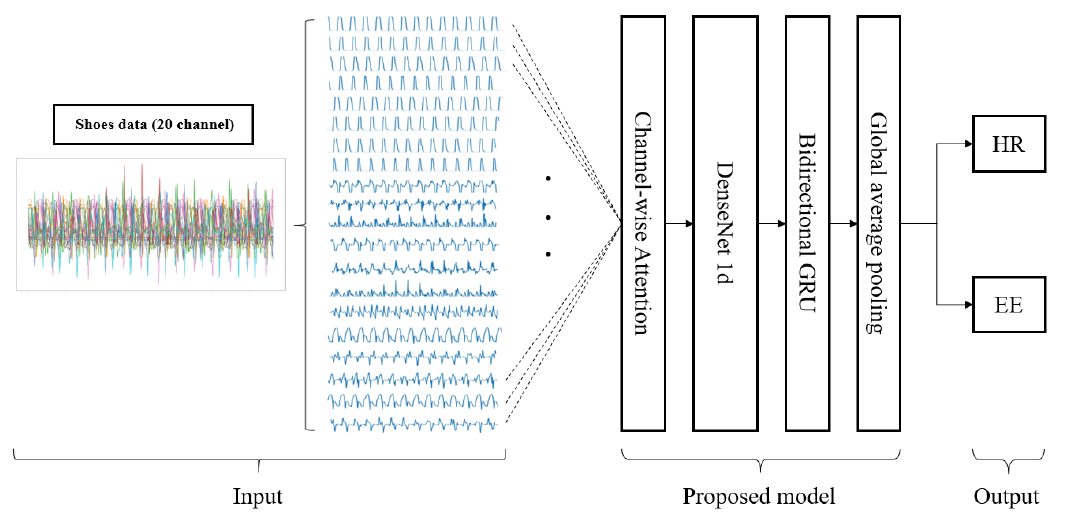
Figure 7. Structure of the proposed model. The shoe data from 20 channel sensors are fed into the input of the model and the channel-wise attention layer increases the intensity of the significant channels. The spatial features from the multi-channel data are extracted using DenseNet, and the temporal features are produced through Bi-GRU. Finally, HR and EE are estimated after the global average pooling (GAP)